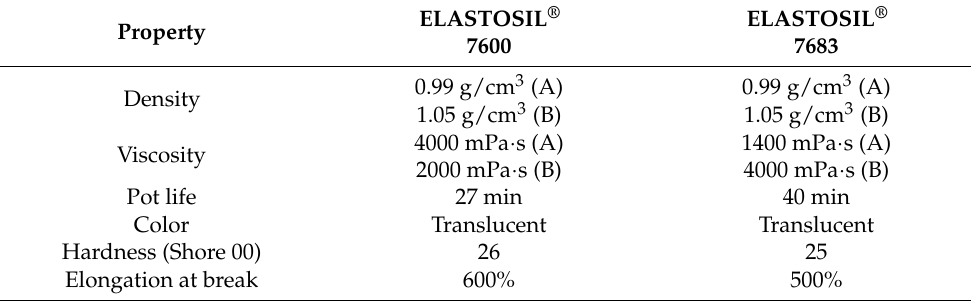
Table 1. Physical and mechanical properties of the elastomeric matrix base material.